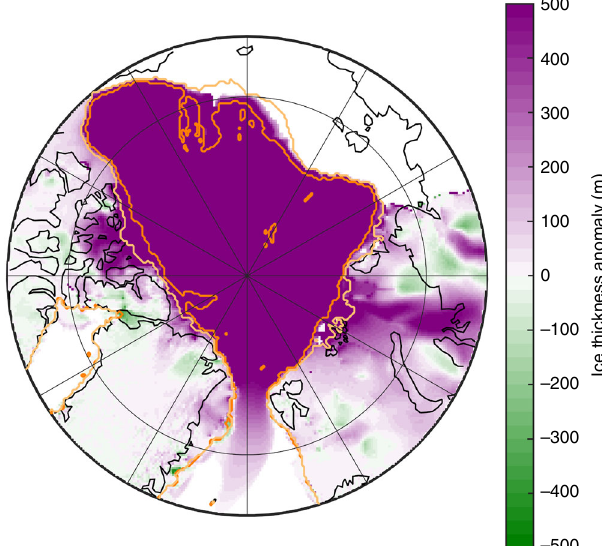
Fig. 6 Impact of an Arctic ice shelf on grounding line position and grounded ice thickness. As simulation shown in Fig. 3b, showing thickness difference relative to a simulation without an Arctic ice shelf. Light orange line shows grounding line position in absence of an Arctic ice shelf, dark orange line is grounding line with an Arctic ice shelf. Note thickening of the terrestrial ice sheets, in particular in ice stream